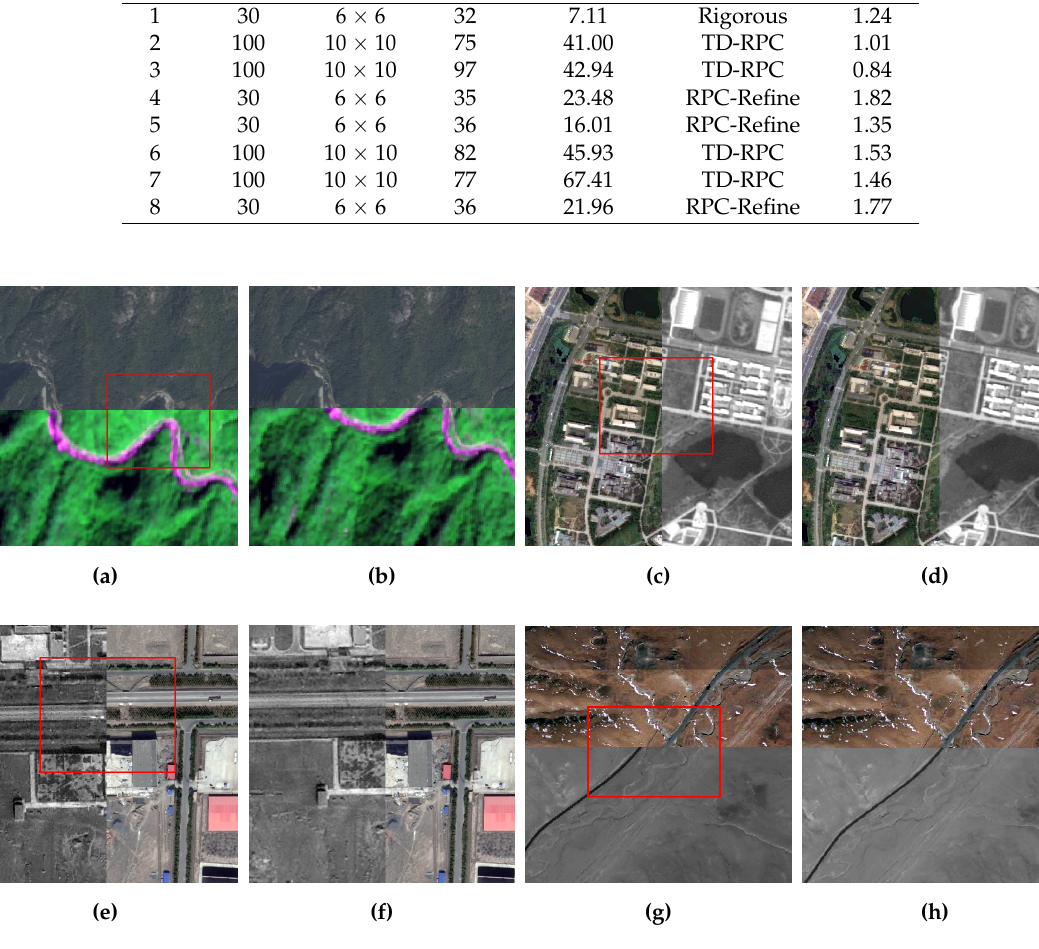
Figure 11. Layer swiping between sensed images and online aerial maps in Tests 4, 6, 7 and 8. ( a ) and ( b ) are from Test 4, and the top ones are Bing aerial maps, while the lower one in ( a ) is the warped ZY-3 image using vendor-provided RPC and the lower one in ( b ) is the rectified ZY-3 image using RPC refinement; ( c ) and ( d ) are from Test 6, and the left are Bing aerial maps, while the right one in ( c ) is the Spot-5 image of Level 2 and the right one in ( d ) is the rectified Spot-5 image using terrain-dependent RPC; ( e ) and ( f ) are from Test 7, and the right are Bing aerial maps, while the left one in ( e ) is the Theos image of Level 2 and the left one in ( f ) is the rectified Theos image using terrain-dependent RPC; ( g ) and ( h ) are from Test 8, and the upper are Bing aerial maps, while the lower one in ( e ) is the warped GF-1 image using vendor-provided RPC and the lower one in ( f ) is the rectified GF-1 image using RPC